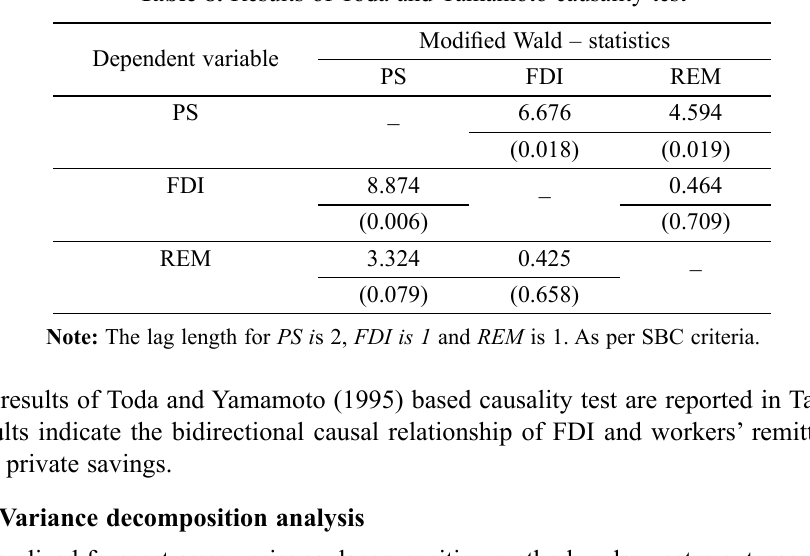
Table 8. Results of Toda and Yamamoto causality